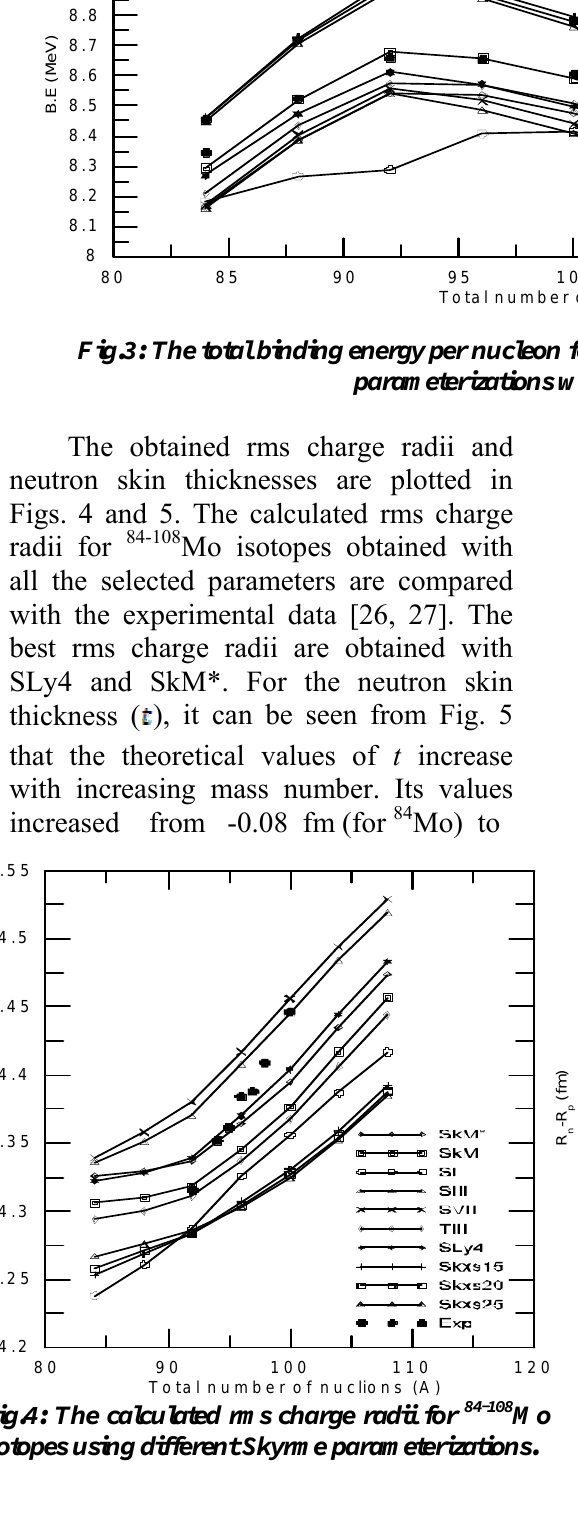
Fig.5: The neutron skin thickness t for 84-108 Mo isotopes against the mass number using different Skyrme